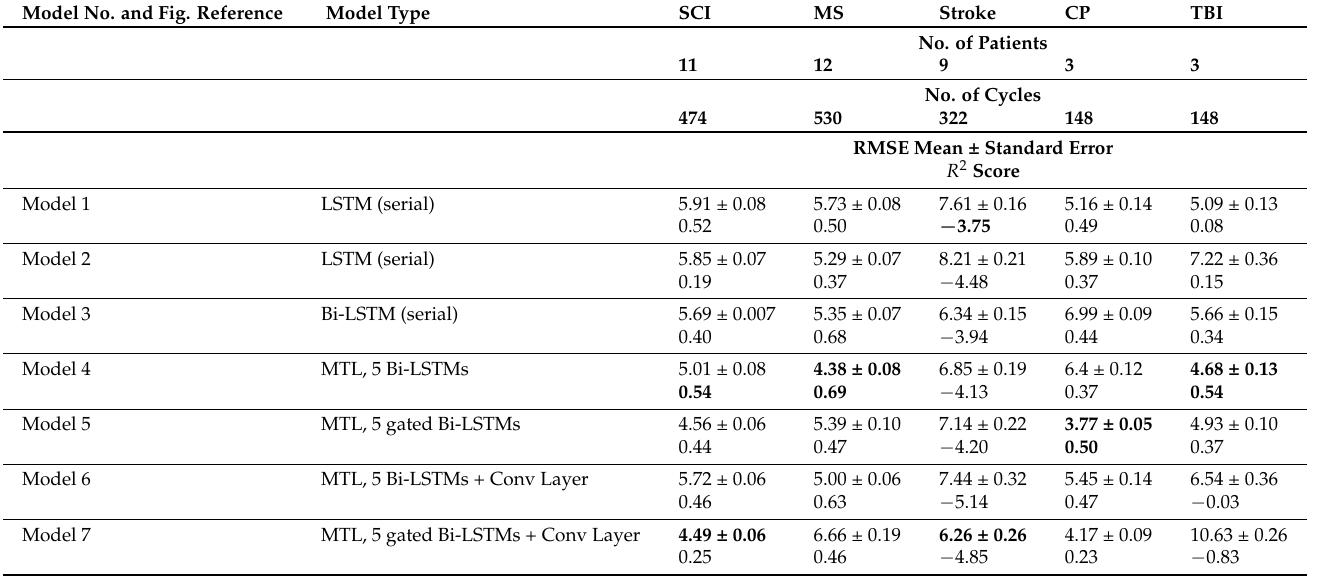
Table 6. Performance of different models in prediction of post-treatment ankle gait with respect to different